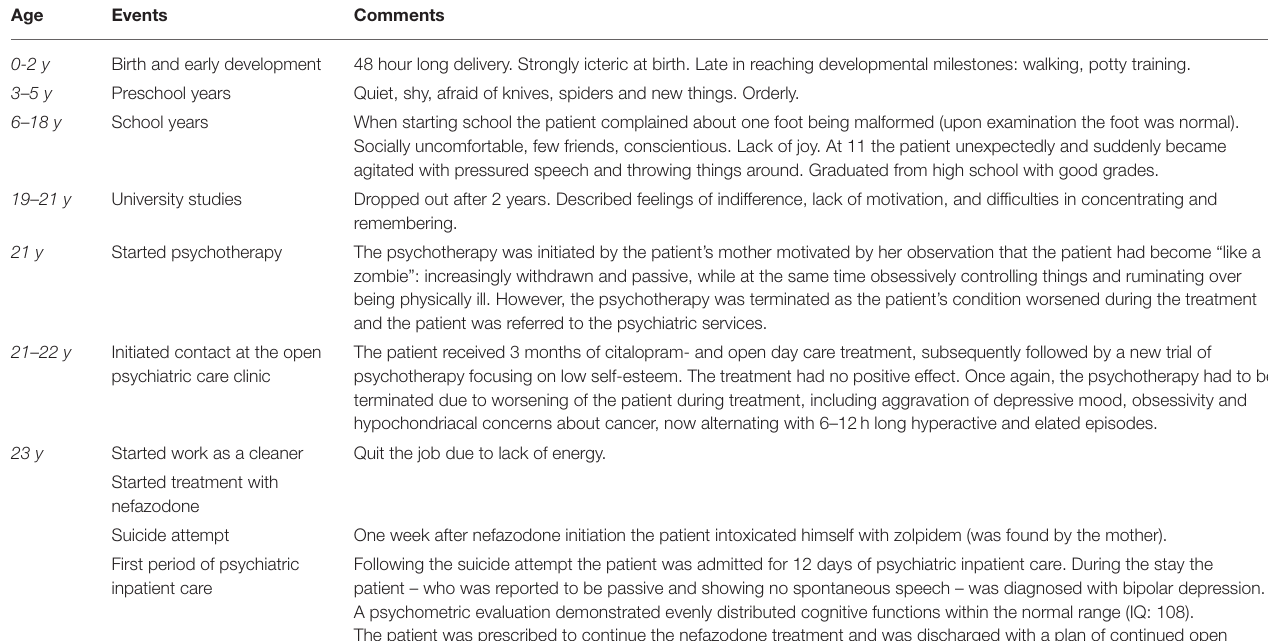
TABLE 1 | Timeline of patient biographic and medical events until 37 years of age.